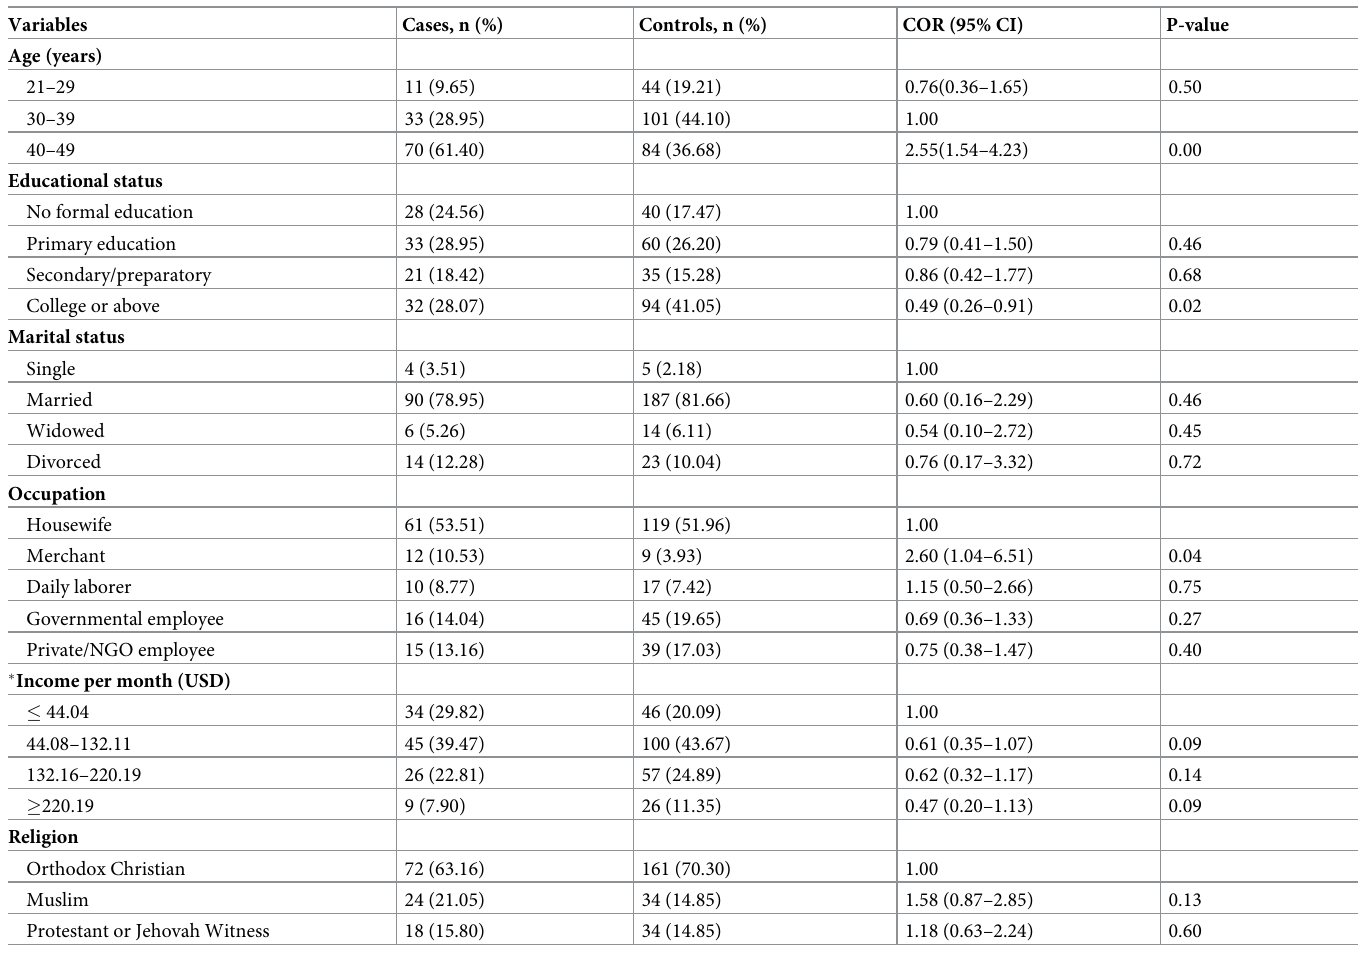
Table 1. Socio-demographic characteristics of women screened for cervical cancer in Addis Ababa, Ethiopia,